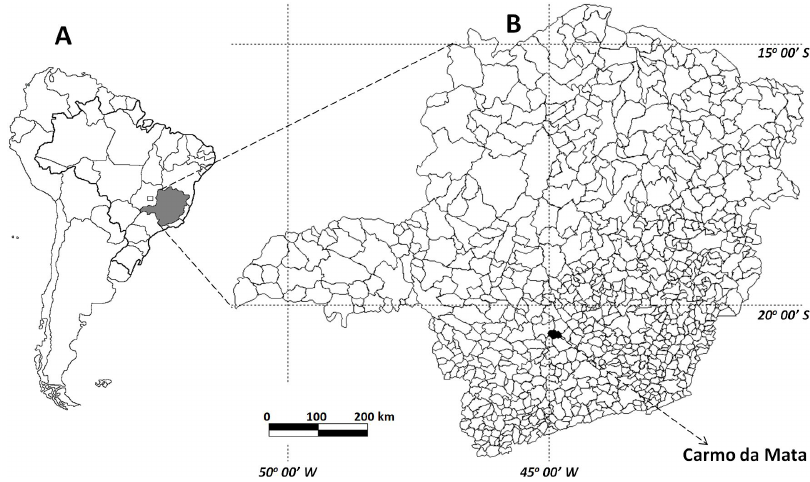
Figure 1. Location map of the municipality of Carmo da Mata, Minas Gerais State, Brazil. A: South